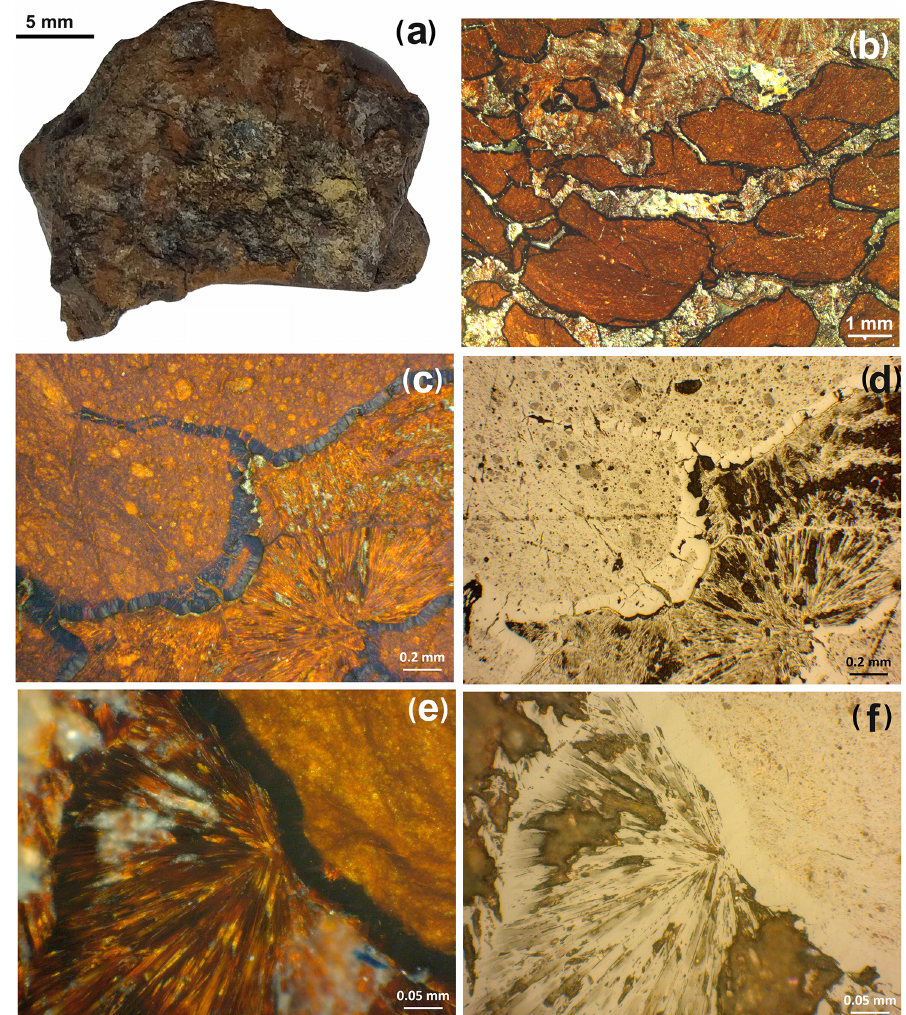
Figure 2. Brown iron ore nodule, sample 5889/1.6. (a) General view; (b) clastic structure of brown iron ore; (c, d) fragment of psephitic ferruginous rocks with crusts of compact Fe and Mn oxyhydroxides; (e, f) radial radiant aggregate of acicular goethite with interstitial clay minerals between fragments of ferruginous rocks ( b – oblique light; c–f – reflected light; c, e – with analyzer; d, f – without